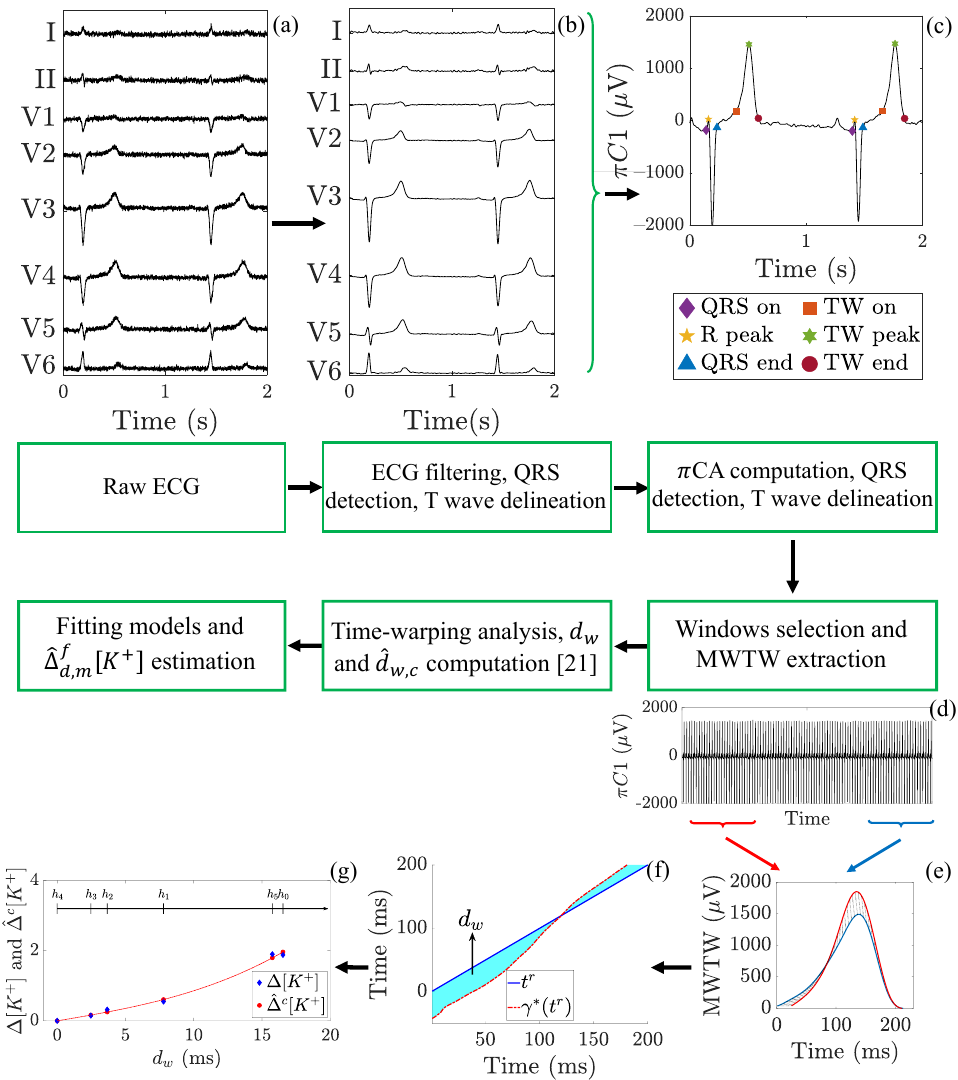
Figure 3. Flow chart showing the ECG processing steps performed in this study. ( a ) Raw ECG (the eight independent leads I, II, V1 to V6 are shown) obtained from one of the enrolled ESRD-HD patients (see Section 2). ( b ) Preprocessed ECG as described in Section 3.1. ( c ) π CA is applied and both QRS complexes and T-waves (TW in the legend) are detected and delineated as detailed in Section 3.2. ( d ) From 2-min wide windows, ( e ) a mean warped T-wave (MWTW) is extracted and ( f ) T-wave morphology markers d w and ˆ d w , c are computed as stated in Section 3.3. ( g ) The fitting [ K + ] estimation are evaluated as in Section 3.5. In this example, a cubic model with models for ˆ ∆ f d , m m = a is